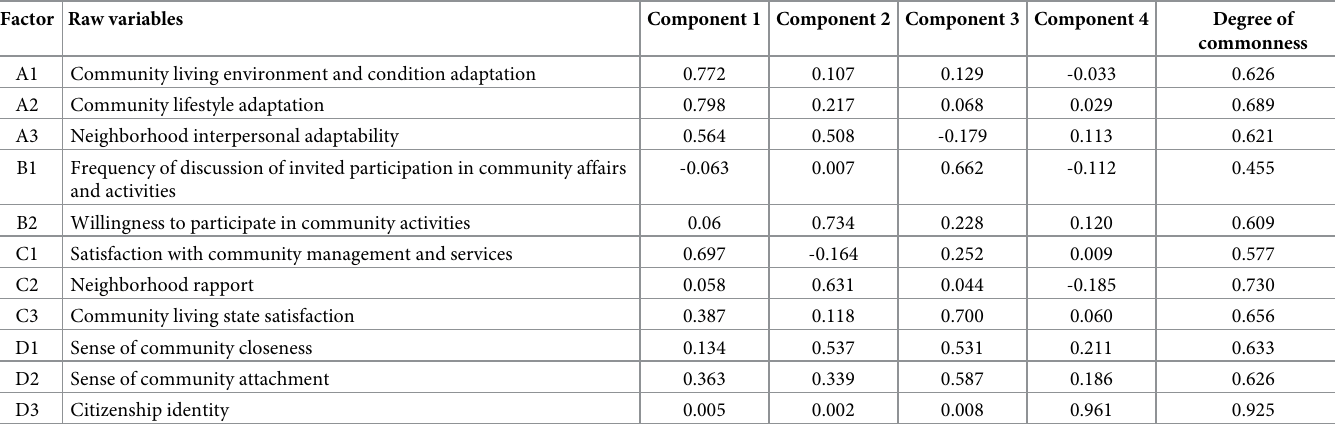
Table 3. Composition matrix after rotation.